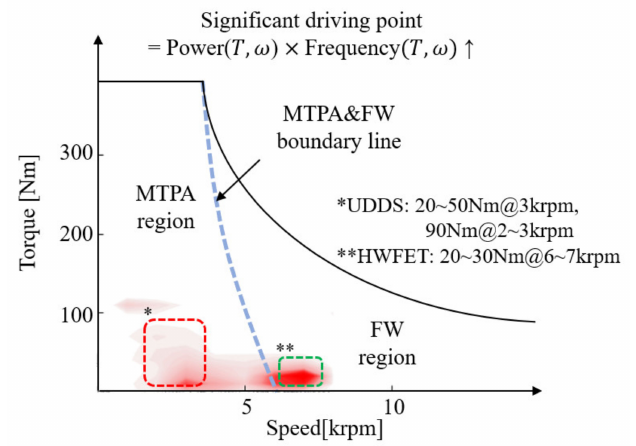
Figure 3. Distribution of significant driving points on the speed and torque plane with combined driving cycle (55% UDDS and 45%